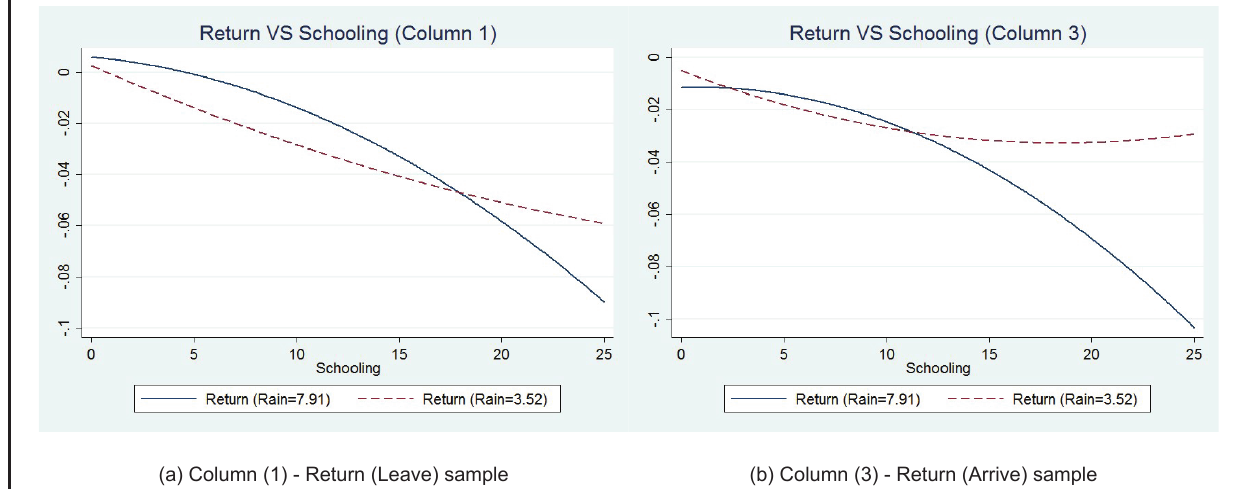
The relationship between years of schooling and return probabilities changes with rainfall.